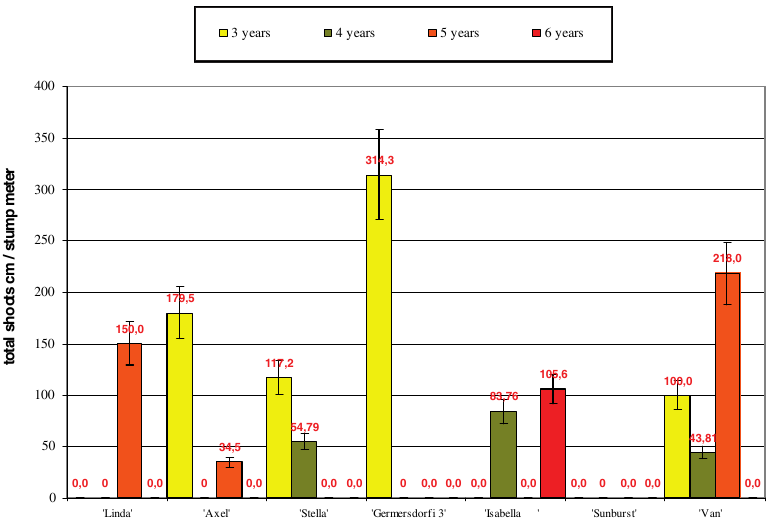
Figure 2: Abilities of regeneration on parts of different age considering all shoot lengths in cherry varieties (Debrecen-Pallag,